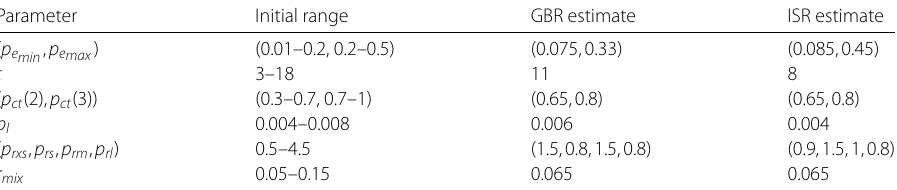
Table 3 Country-dependent parameters, with initial and final estimates for GBR and ISR Parameter Initial range GBR